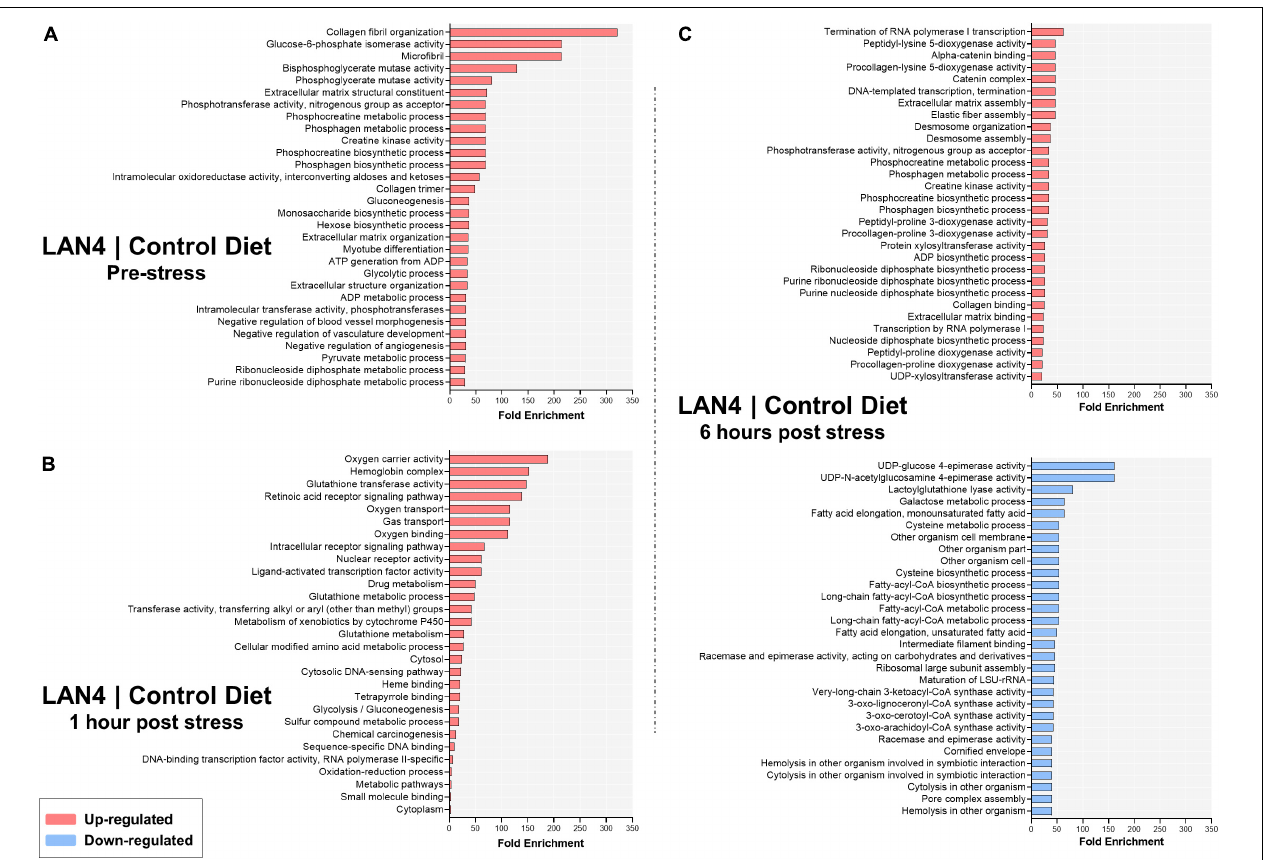
FIGURE 5 | Top #30 terms significantly enriched (minGSSize = 2) in gills from fish fed LAN4 diet compared to fish fed control diet (CD). The list is ordered by fold enrichment. (A) Terms in LAN4 compared to CD at the pre-stress group. (B) Terms in LAN4 compared to CD at 1 h post-stress. (C) Terms in LAN4 compared to CD at 6 h post-stress. In red: upregulated terms. In light blue: downregulated